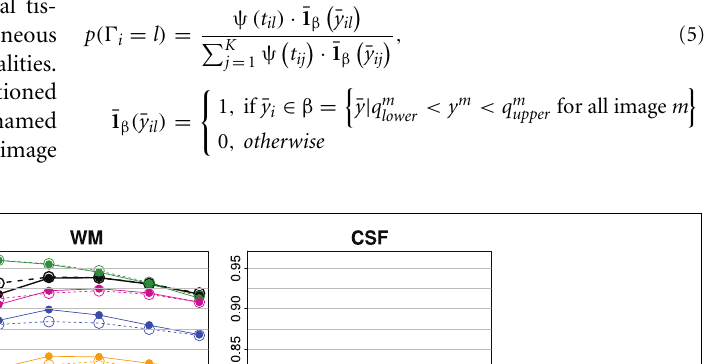
without one (blue). SyN registration (pink, black) also improved tissue segmentation agreement further comparing to the affine (yellow, blue). Note that the performance with SyN registration utilizing only three tissue types outperformed any affine registration method. Multi-modal input trial , T1 and T2, (black) comparing to T1 Only (green) seems helpful when there is more